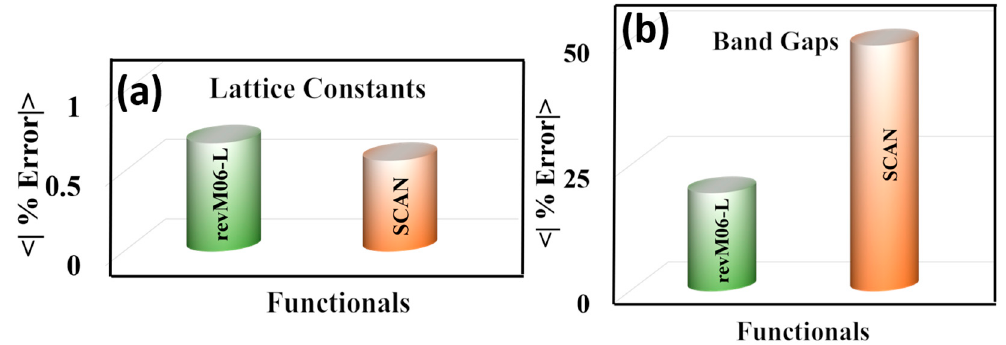
Figure 6. Mean unsigned percentage errors (MUPE) of ( a ) lattice constants and ( b ) band gaps of semiconductors.